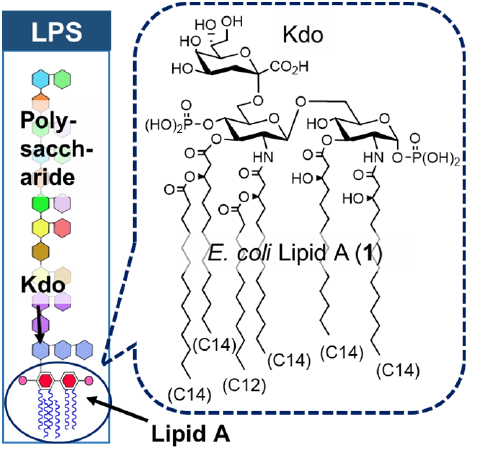
Figure 2. E. coli LPS and Kdo-lipid A.